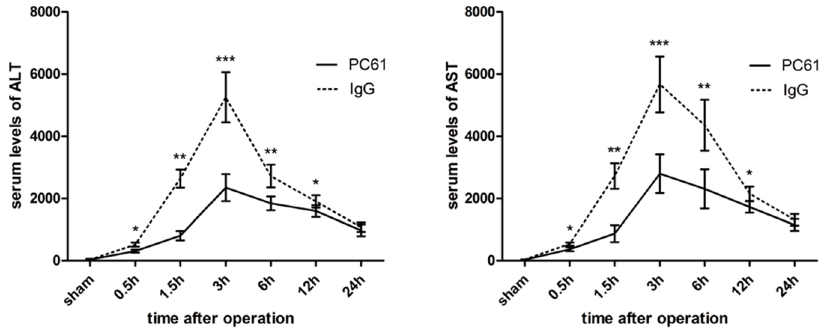
Figure 2. Anti-CD25 mAb pretreatment preserved liver function after hepatic IR. Serum ALT and AST levels in IgG and PC61 group (n=6) after partial ischemia and 0.5, 1.5, 3, 6, 12, 24 hours reperfusion. Sham controls (n=3) displayed blood sample at 3 hours after reperfusion. Results are